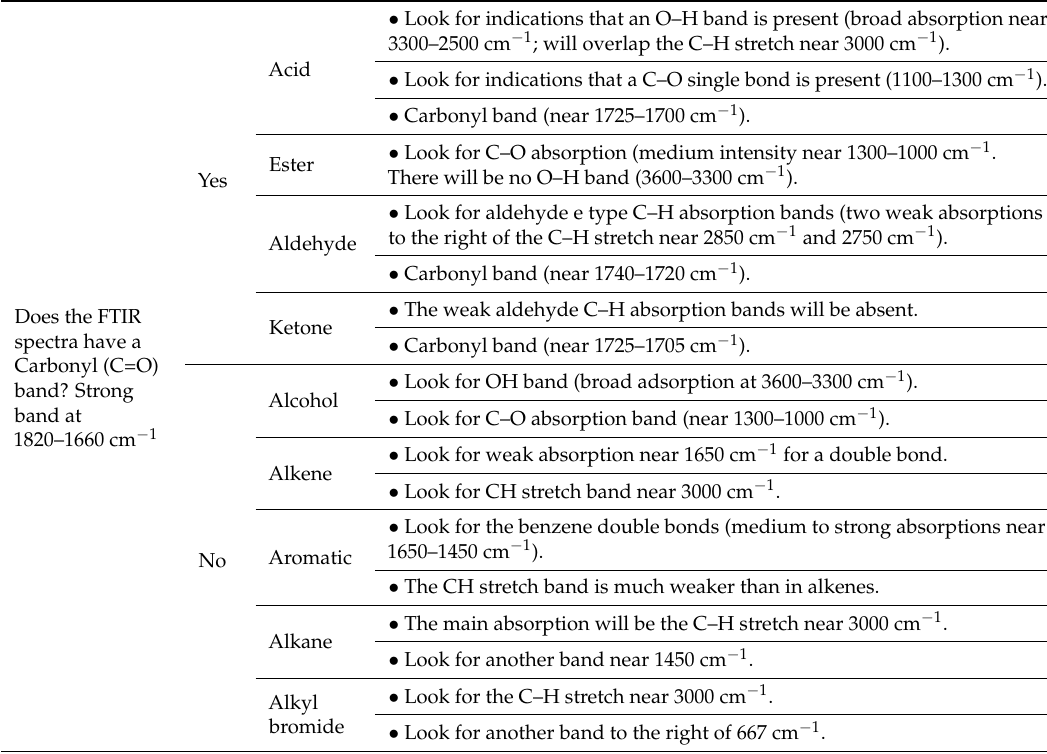
Table 2. Basic principles for FTIR metabolite